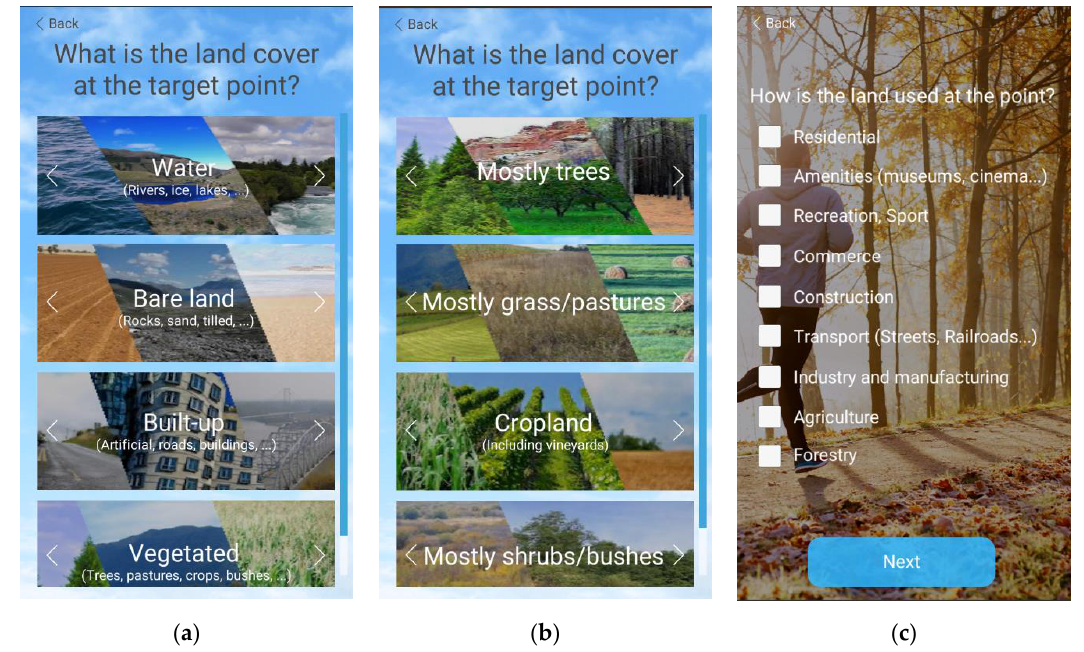
Figure 3. Screenshots from the FotoQuest Go Europe app showing ( a , b ) the hierarchical land cover (LC) classification and ( c ) the land use (LU) classification.